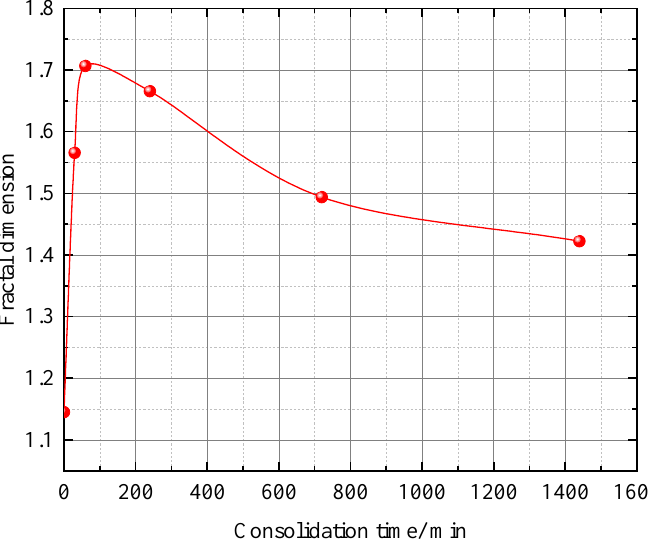
Figure 12. The curve of fractal dimension of soil pores under different consolidation time.